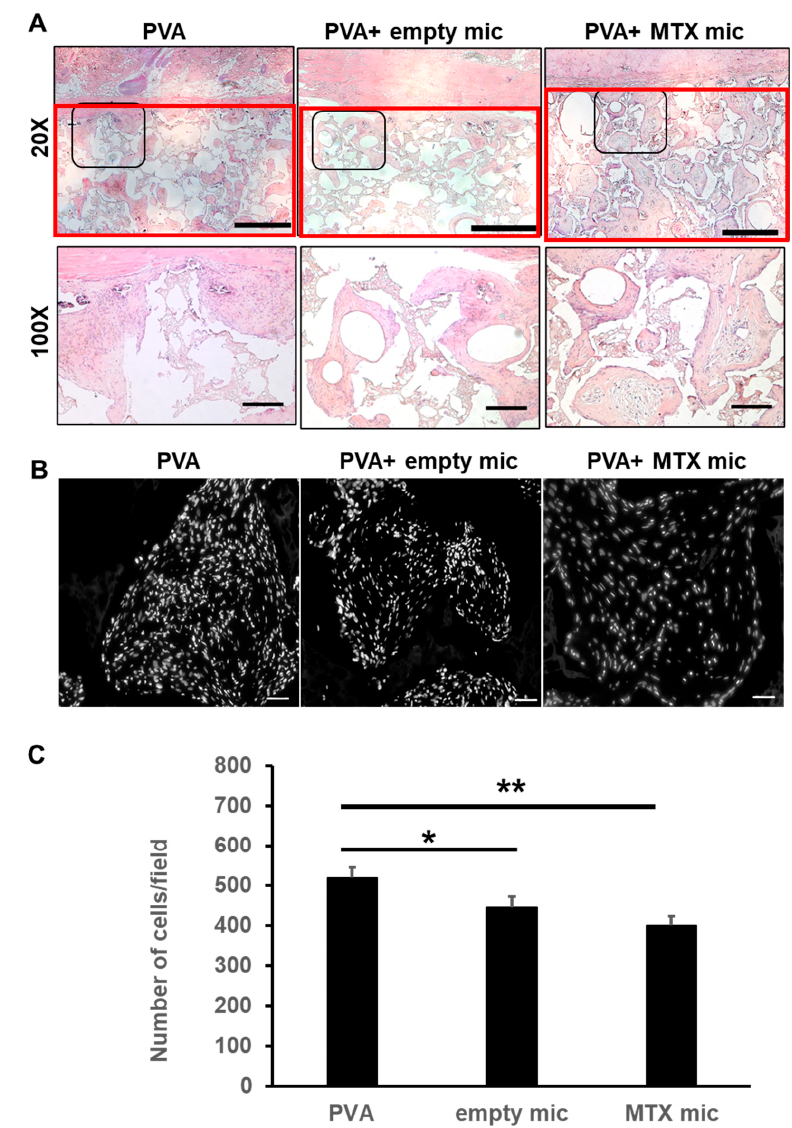
Figure 5. Tissue cellularity and growth in PVA sponges from skin samples after 62 days. ( A ) H&E stained sections show comparable new tissue growth red marking area) for all three groups: (i) control PVA; (ii) PVA containing control microspheres; and (iii) PVA + MTX microspheres. Scale bar = 1 mm at 20 and 200 µ m at 100 magnifications. ( B ) Representative images of the sections (DAPI stained, 200 × , 50 µ m scale bar). ( C ) Quantitative analysis of the number of cells in the interior of PVA showed that the total number of cells/fields in PVA control images (519.5 ± 25.5 cells/field) was significantly higher than the PVA+ control microspheres (445.3 ± 25.5 cells/field) and PVA + MTX microspheres (400.3 ± 22.6 cells/field). n = 3, * p = 0.05, ** p =